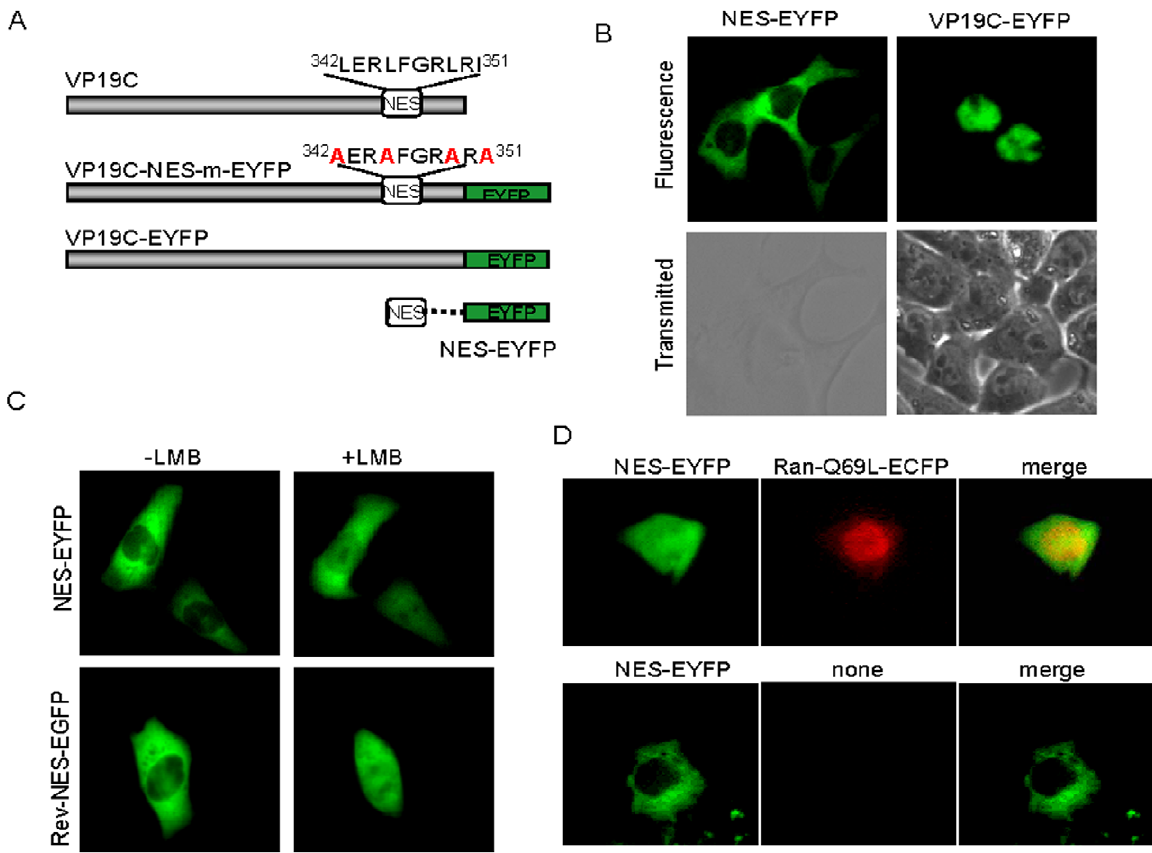
Figure 1. Characterization of the NES and the nuclear export mechanism of the VP19C protein. (A) Schematic diagram of wild-type VP19C and the putative NES fused with EYFP. (B) Subcellular localization of NES-EYFP and VP19C-EYFP. (C) The NES of VP19C mediated the nuclear export of EYFP via CRM1 dependent pathway. COS-7 cells were transiently transfected with plasmids encoding NES-EYFP and Rev-NES-EYFP (positive control). The cells were incubated in the absence or presence of 10 ng/ml LMB 24 h after transfection. (D) The NES of VP19C mediated the nuclear export of EYFP via RanGTP. COS-7 cells were co-transfected with pNES-EYFP with or without pRan-Q69L-ECFP. Both fluorescent images of EYFP and ECFP fusion proteins were presented in pseudocolor, green and red, respectively. Each image is representative of the vast majority of the cells observed.